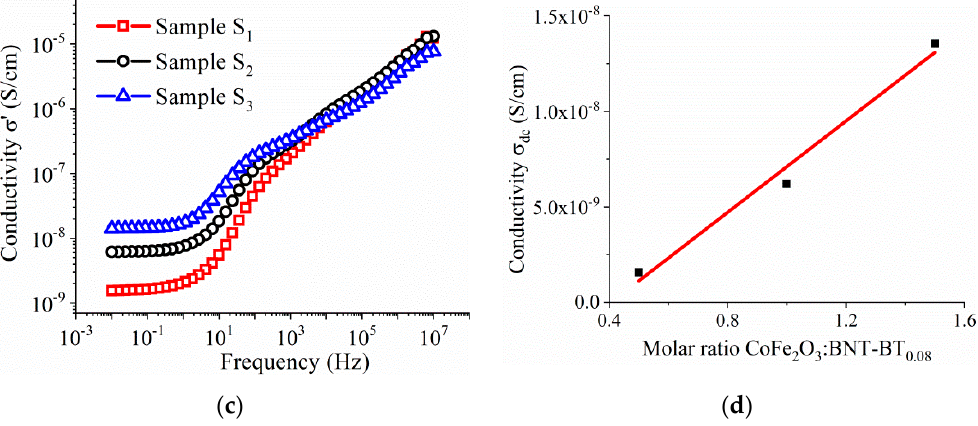
Figure 11. Frequency dependence of: ( a ) the real part of the permittivity ( ɛ ˊ ). The inset shows the imaginary part of the permittivity, ( b ) loss tangent, ( c ) AC conductivity for the sintered ceramics samples S 1 – S 3 , and ( d ) the DC conductivity as function of the CoFe 2 O 4 content.